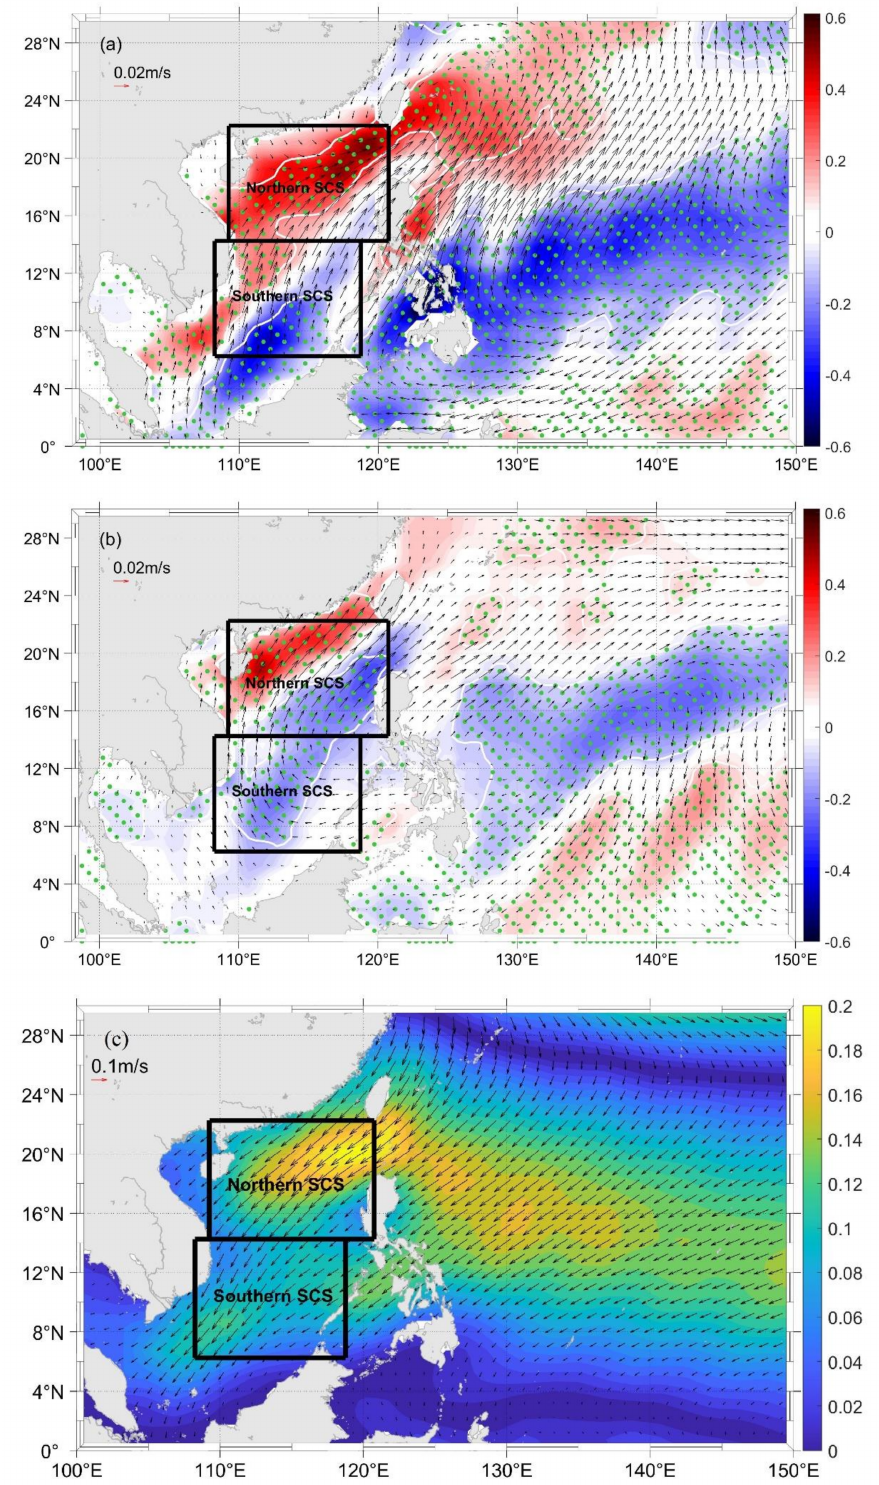
Figure 9. The composites of wind stress anomalies (in N / m 2 ) during mature winters of ( a ) EP El Niño and ( b ) CP El Niño events. The arrows give the direction and magnitude, and the color indicates